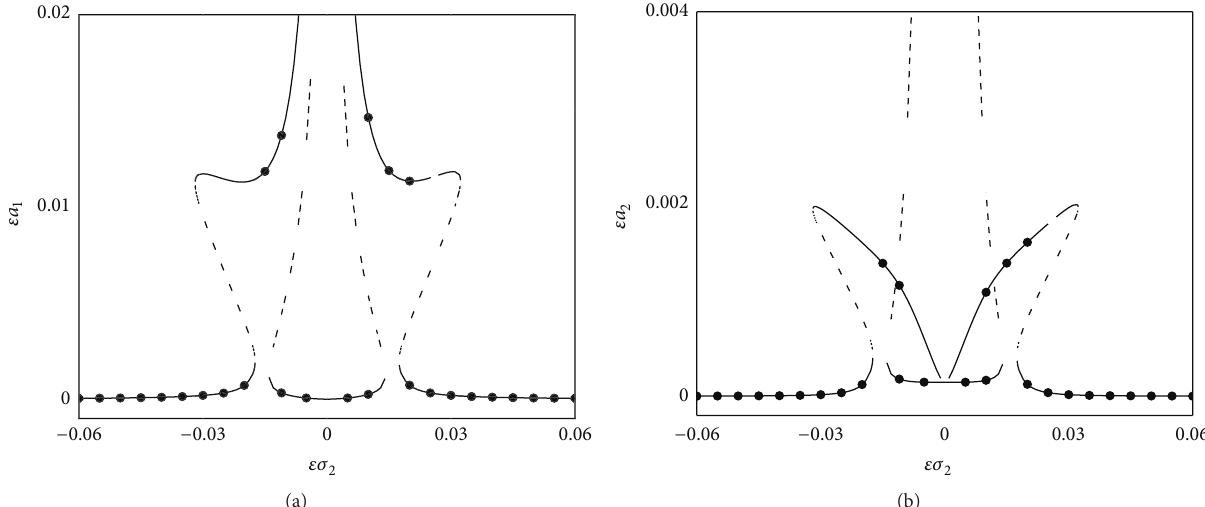
Figure 21: Comparisons in the difference resonance: (a) the first mode and (b) the second